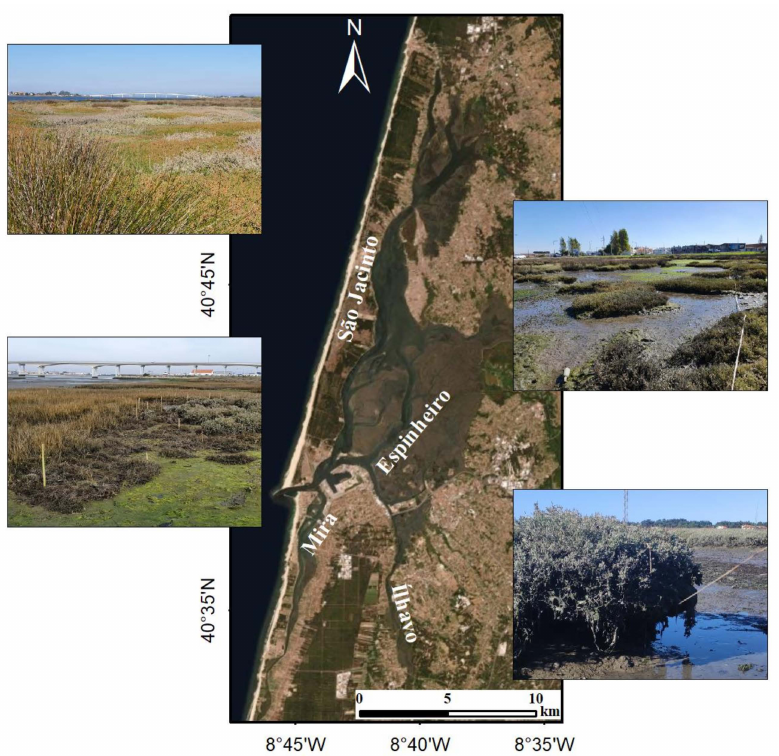
Figure 1. Map of Ria de Aveiro depicting the main channels with panoramas of the studied salt